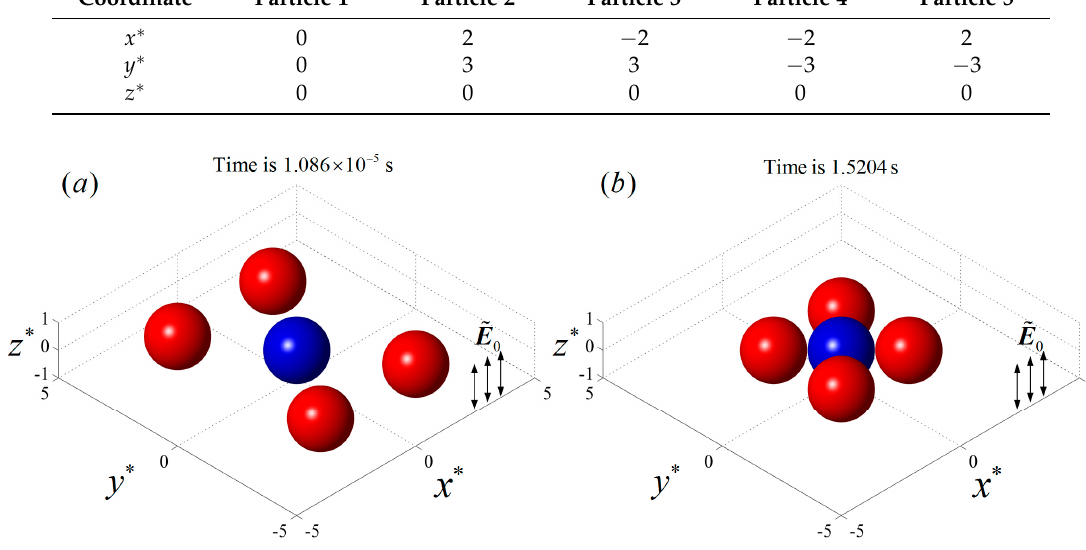
Figure 4. The DEP interaction of five particles initially positioned on a plane perpendicular to an AC electric field with (cid:101) E 0 = 0.02 and f = 10 3 Hz. ( a ) The initial particle locations; ( b ) the final cross-shaped particle chain. The blue and red colors denote pDEP and nDEP particles, respectively.